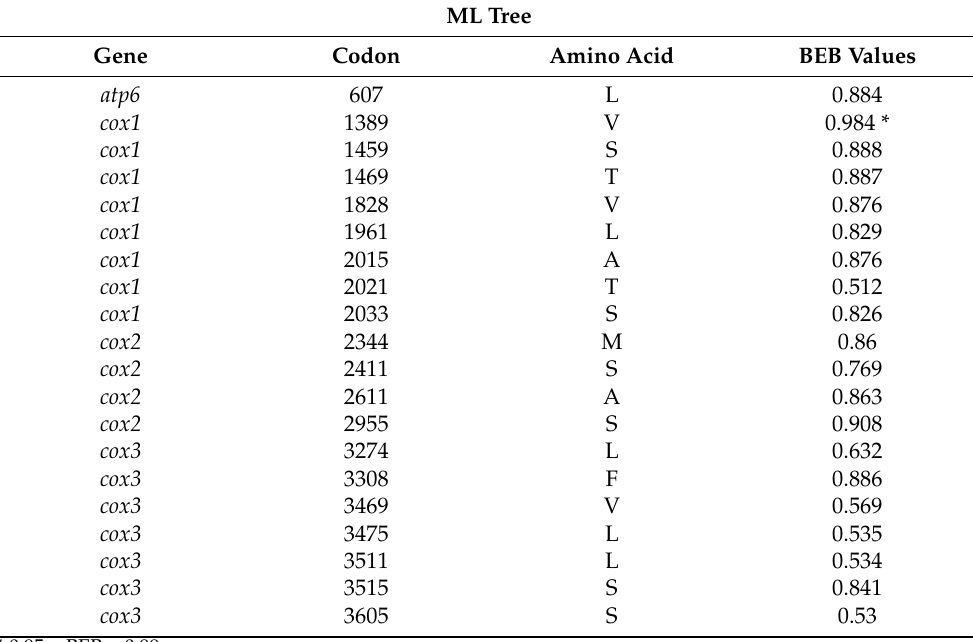
Table 4. Possible sites under positive selection in Eucrate crenata